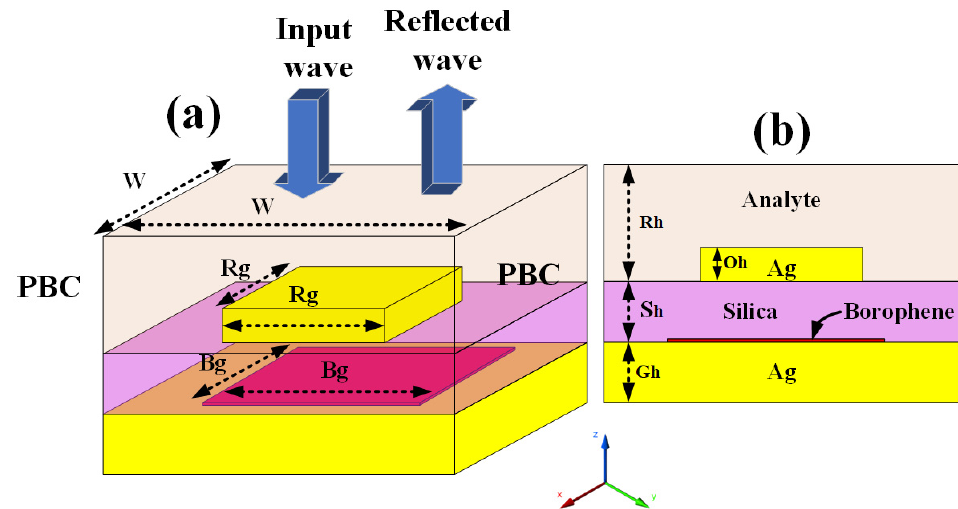
Figure 1. Schematic of the borophene based refractive index sensor. ( a ) Three-dimensional view with the stacked structure Silver-Borophene-Silica-Silver-analyte/sensing medium. ( b ) side view of the proposed structure.